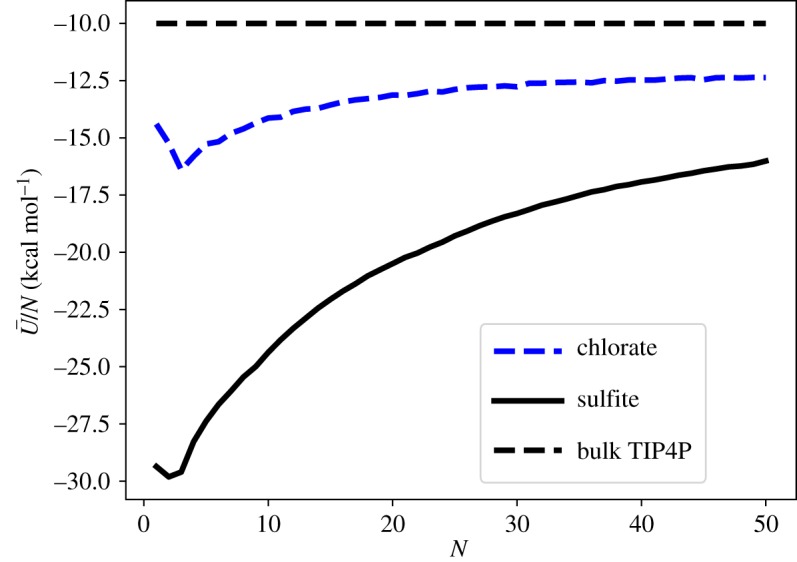
Boltzmann weighted interaction energy per water molecule for SO32−(H2O)N and ClO3−(H2O)N clusters in the range 1≤N≤50. (Online version in colour.)